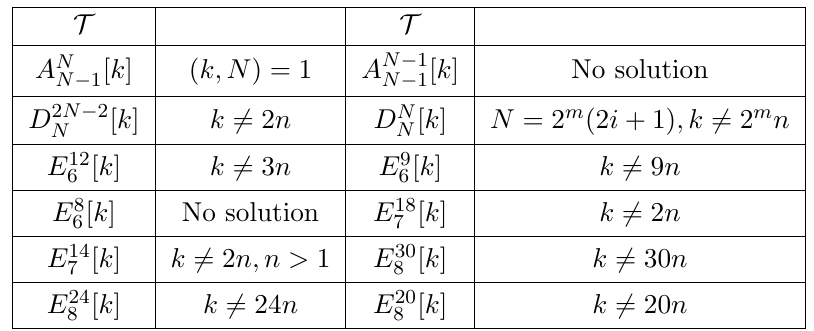
Table 2 . Constraint on k so that the irregular singularity J b [ k ] has no (cid:13)avor symmetry. Here n 2 Z